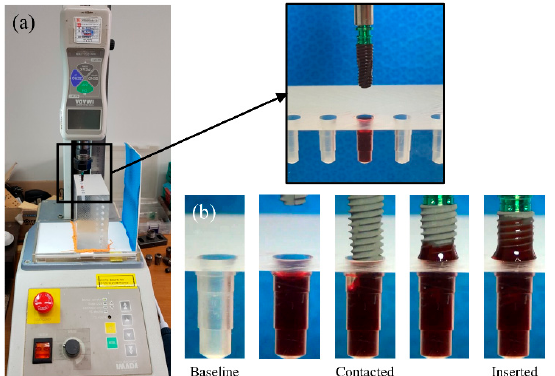
Figure 2. In vitro test of dynamic surface wettability: ( a ) a transparent acrylic plate with implant holes and the implant fixture in a push–pull gauge; ( b ) baseline, contact of the implant fixture with the blood, and whole insertion of implant fixture into the hole.